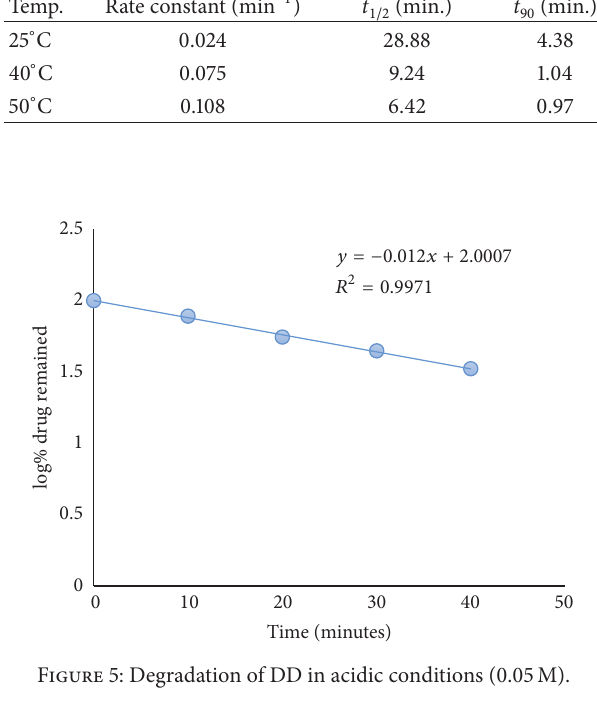
Table 2: Within-day and between-day precision data for DD and PHZ.